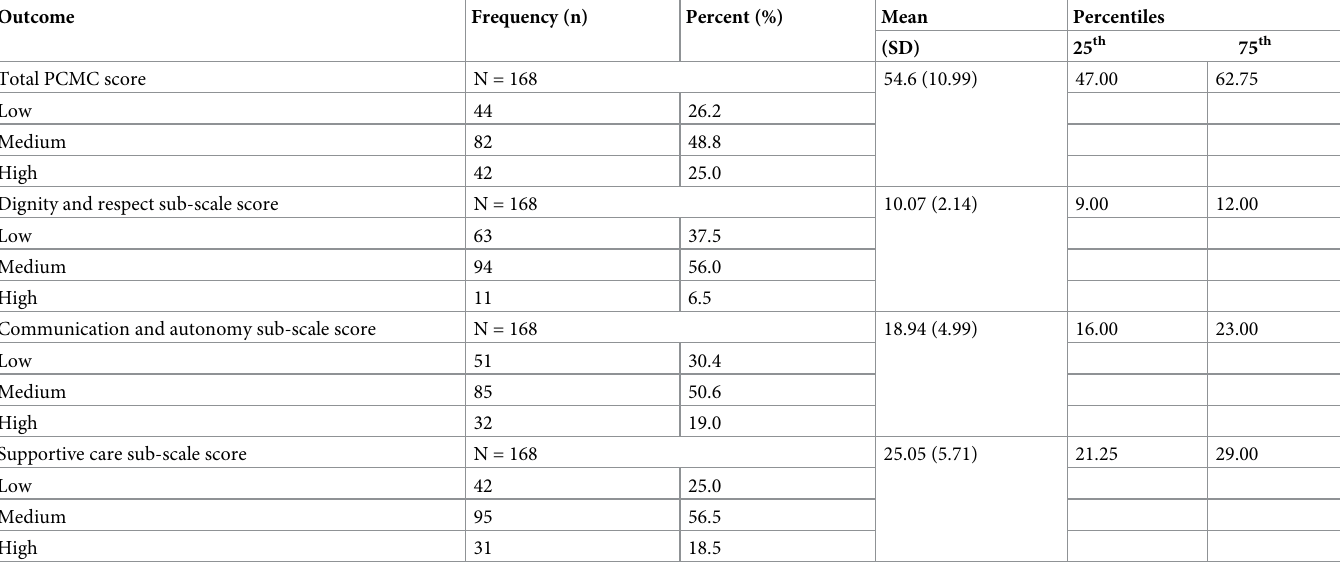
Table 5. Total person-centred maternity care and sub-scale